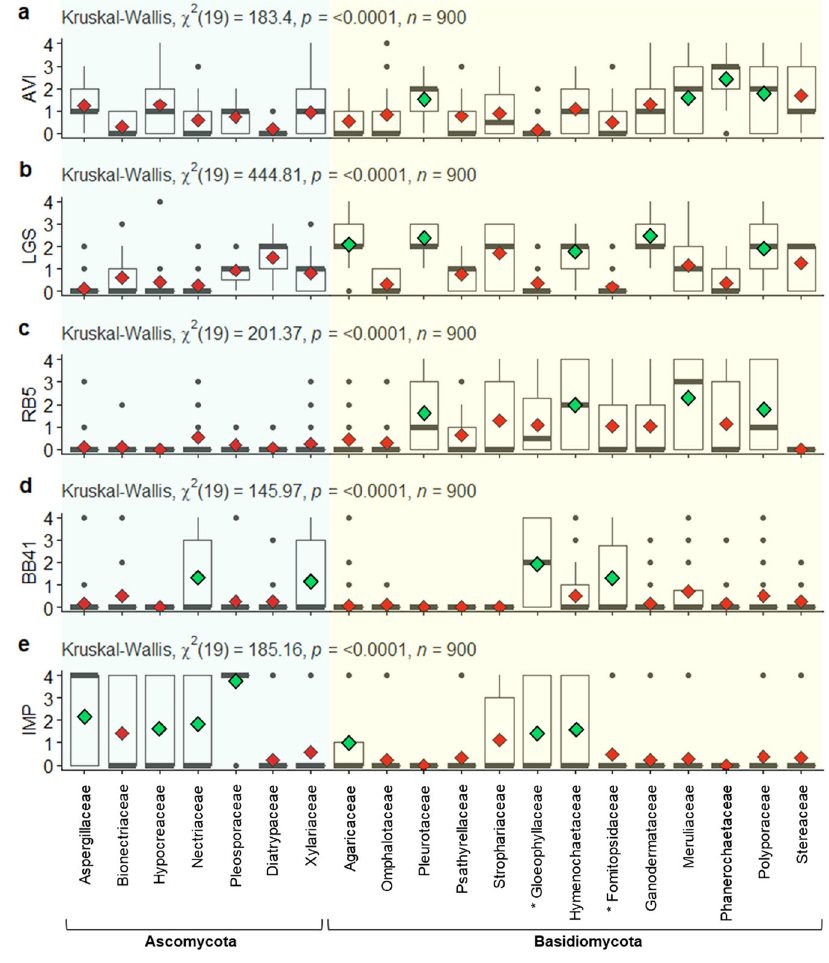
Fig. 6 Box plots showing the fungal family-dependent distribution of phenotypic scores. For each fungal family, and each target compound ( a – e ), the median score (thick gray bars) and mean score (red or green diamonds) are shown. For a given target compound, green diamonds show families with a mean score signi fi cantly higher than other families. Outliers are represented by dots. Families of brown-rot fungi are marked by an asterisk. For each target compound, non-parametric Kruskal – Wallis test indicates ( p value and χ 2 ) signi fi cative differences between fungal families. Wilcoxon signed-rank test were computed to compare paired data (i.e., family to family; p values are shown in Supplementary Data